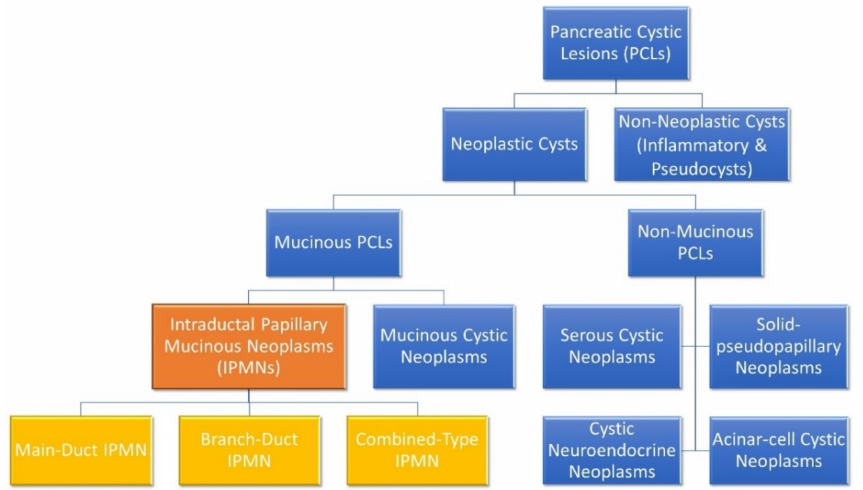
Figure 1. Molecular subgroups of pancreatic cystic lesions. Intraductal papillary mucinous neoplasms (IPMNs) and their distinct subclassifications are highlighted. IPMNs are the most common subgroup and are responsible for 38% of PCLs, while mucinous cystic neoplasms, serous cystic neoplasms and cystic neuroendocrine neoplasm represent 23%, 16% and 7% of PCLs, respectively [29]. Branch-duct IPMNs are most common (46%), followed by combined-type IPMNs (40%) and main-duct IPMNs (14%)